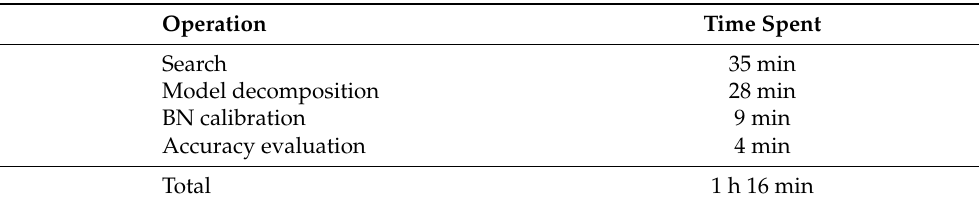
Table 6. Search time summary for the Spatial-SVD compression of ResNet-56 on the CIFAR-10 dataset. Operation Time Spent Search 35 min Model decomposition 28